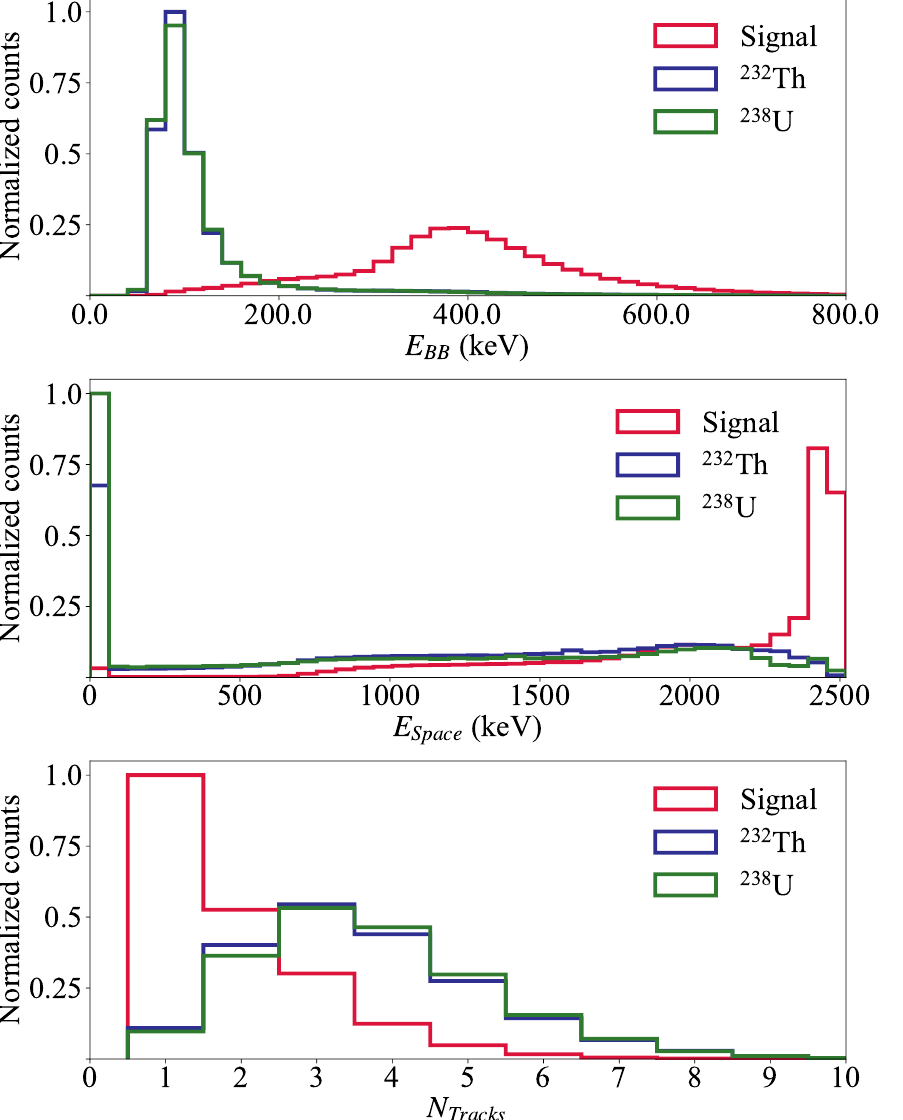
Figure 6. Distributions of E BB , E Space , and N Tracks for the (1 mm, 3%) configuration. E BB represents the deposited energy in Bragg blob with radius 12 mm. E Space represents the energy in a unit volume (57 mm) around the energy-weighted center of the event. N Tracks represents the total number of the event track. The Y axis is normalized by the highest value in each